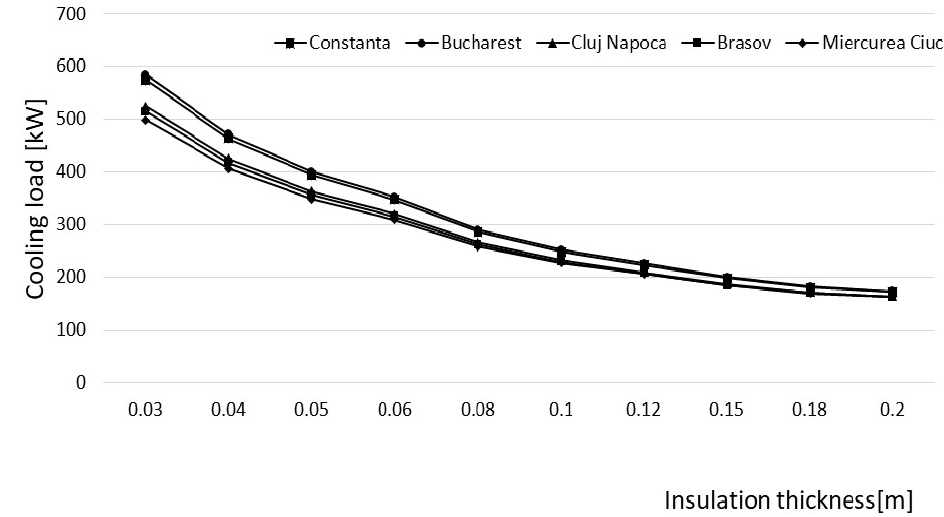
Figure 2. Total cooling load required for refrigeration.